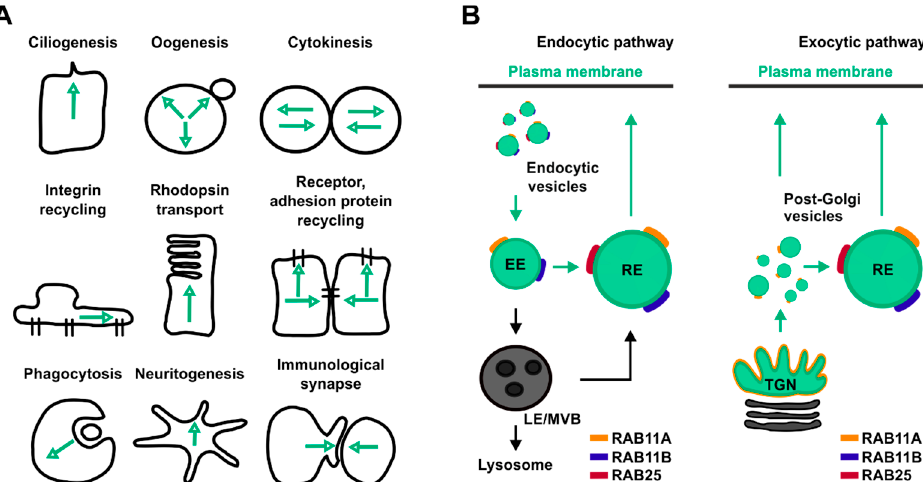
Figure 1. Overview of the main cellular processes and trafficking pathways regulated by RAB11 isoforms. ( A ) Schematic representation of cellular processes controlled by RAB11. Black lines represent cells’ contour, green arrows represent directions of RAB11-mediated trafficking pathways. ( B ) Schematic representation of RAB11 isoform localization in both endocytic (left panel) and exocytic pathways (right panel). Green circles represent RAB11-positive compartments, yellow, blue, red lines represent RAB11A, RAB11B and RAB25, respectively.